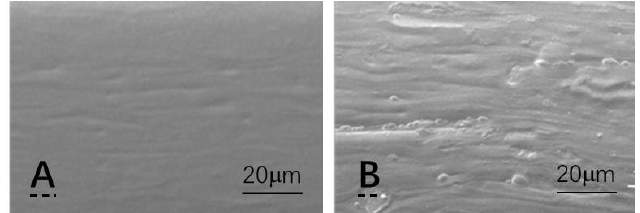
Figure 4. Image of the pure starch film in cross-section using SEM ( A ). The film containing cellulose crystals and laver ( B ) (sample CLX).